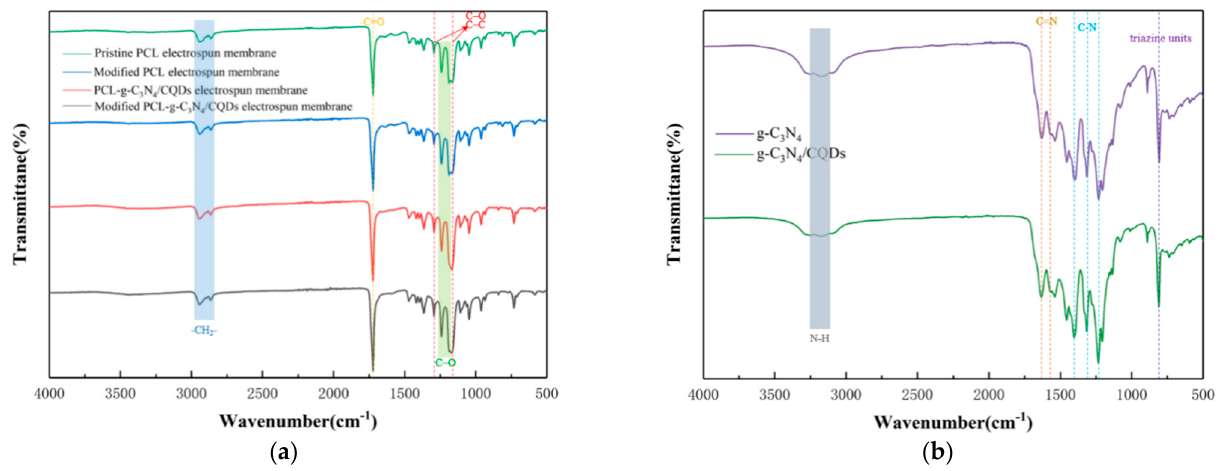
Figure 7. FTIR spectra of ( a ) the as − prepared membranes and ( b ) g-C 3 N 4 , g-C 3 N 4 /CQDs composites.